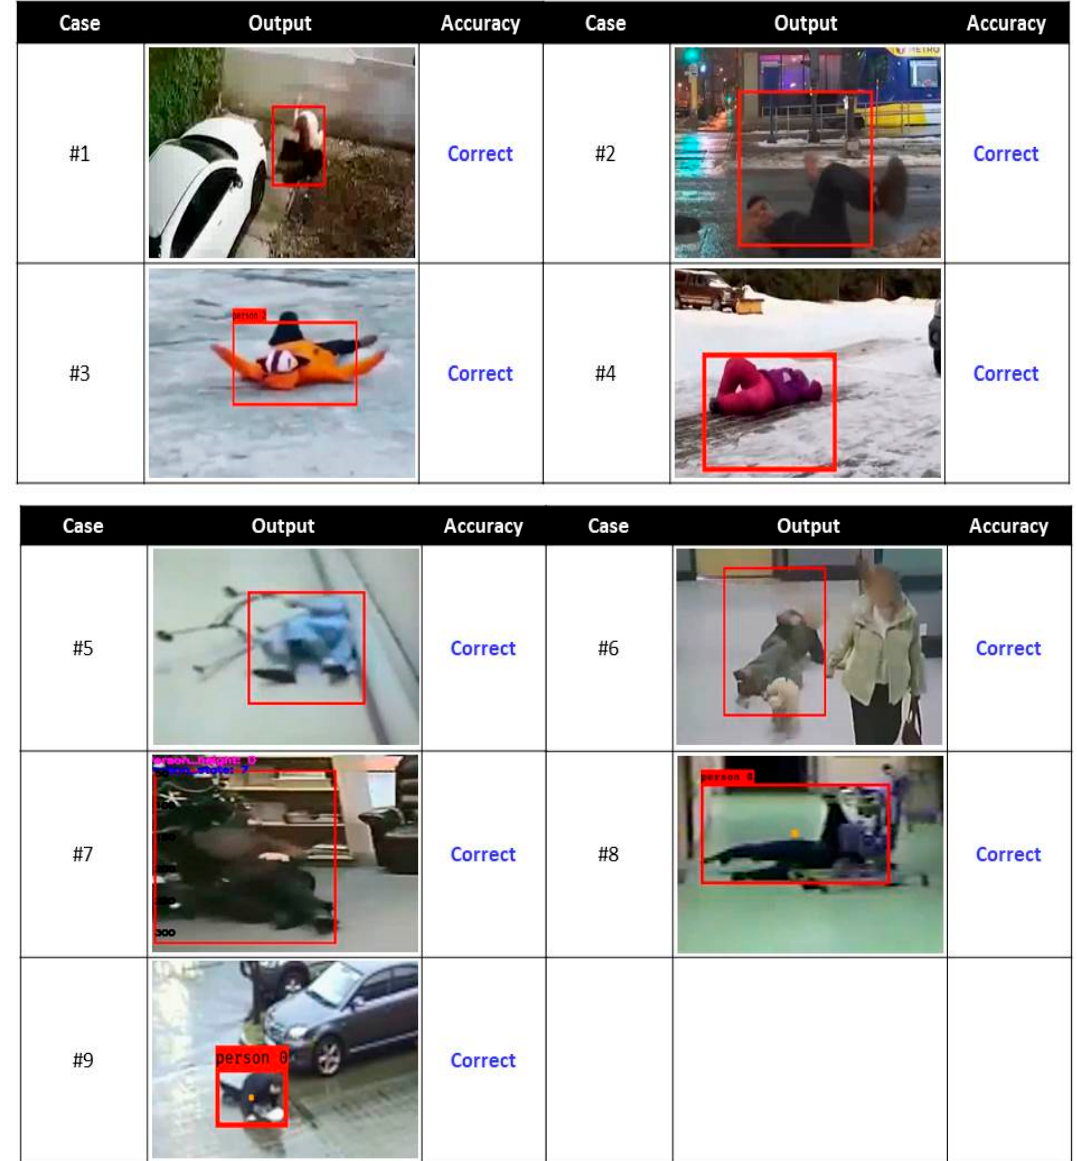
Figure 19. The results of the video case studies.